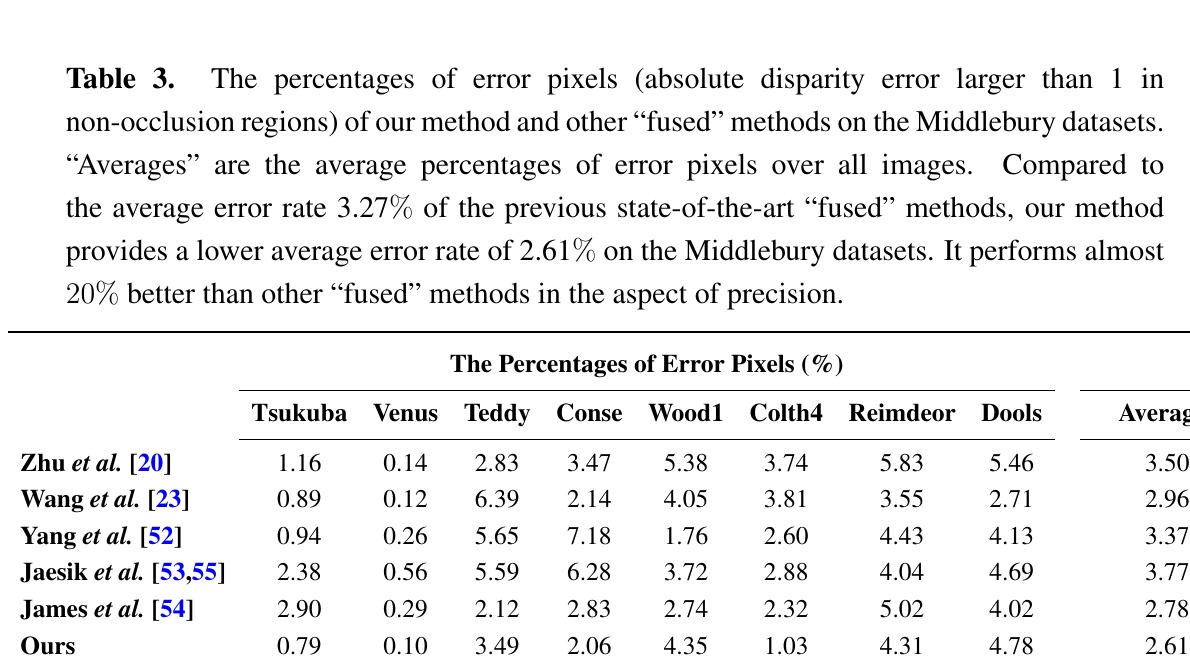
Figure 13. The results of 3D reconstructions. ( a ) Tsukuba; ( b ) Venus; ( c ) Teddy; ( d ) Cones; ( e ) Wood1; ( f ) Cloth4; ( g ) Reindeer; ( h ) Dolls.